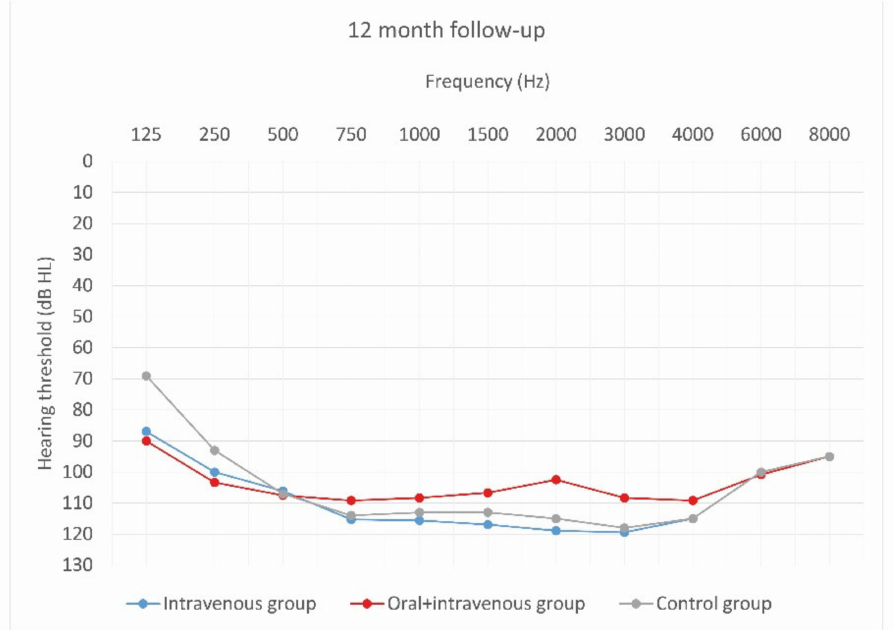
Figure 6. Mean hearing thresholds of patients with standard steroid therapy (i.v. group), patients with prolonged steroid therapy (oral + i.v. group) and control patients in the twelve-month follow-up after CI activation.